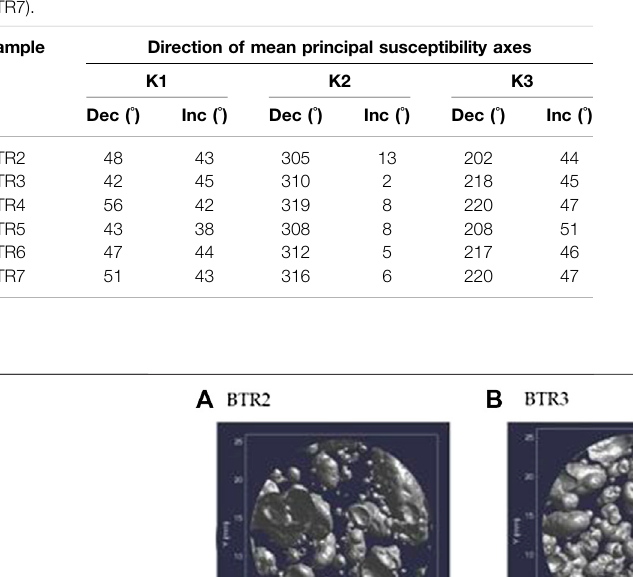
Frontiers in Earth Science |